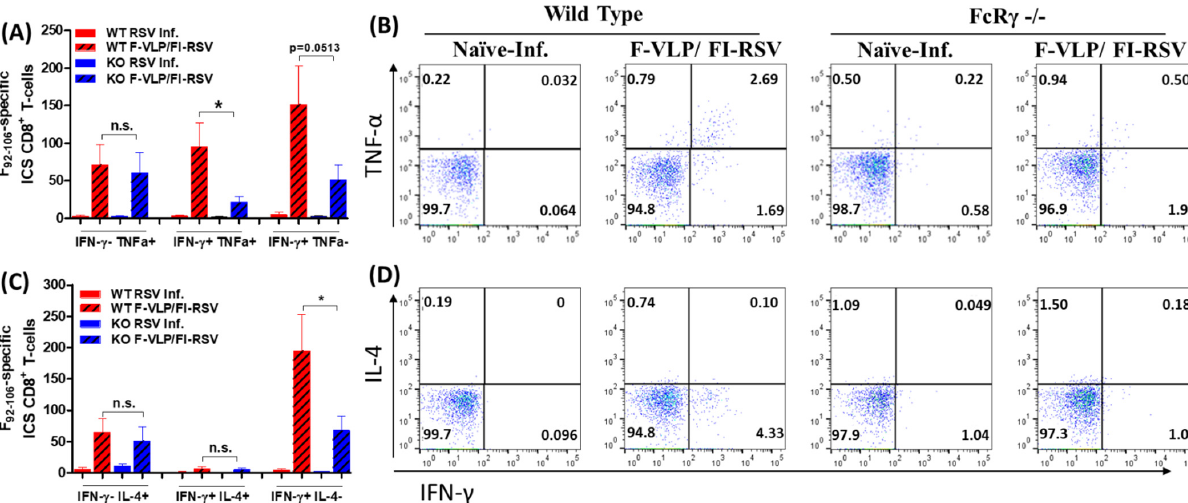
Figure 4. RSV F-specific CD8 T-cells secreting IL-4, TNF- α , and IFN- γ . BAL cells collected from mice ( n = 5 per group) at day 5 post-challenge were stimulated with the RSV-F 92–106 CD8 peptide epitope. ( A ) The numbers and ( B ) populations of CD8+ T-cells secreting IFN- γ (TNF- α -IFN- γ +) or TNF- α (TNF- α +IFN- γ -) out of the total BAL cells collected from individual mice. ( C ) The numbers and ( D ) populations of CD8+ T-cells secreting IL-4 (IL-4+IFN- γ -) or IFN- γ (IL-4 -IFN- γ +) out of the total BAL cells collected from individual mice. Results are presented as mean ± SEM. * p < 0.05, comparing indicated groups. n.s.: not